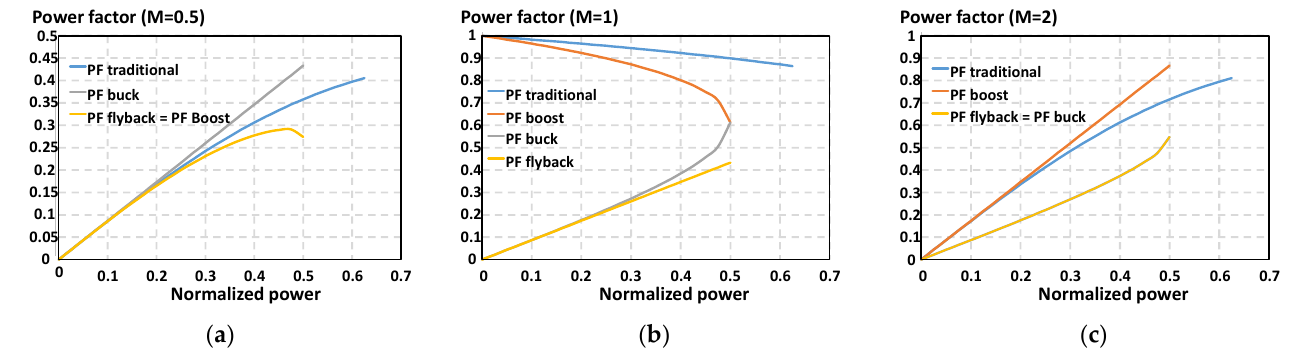
Figure 6. Power factor referred to the input voltage: ( a ) M = 0.5, ( b ) M = 1, and ( c ) M = 2. On the other hand, Figure 7 shows the regions where soft switching can be obtained.